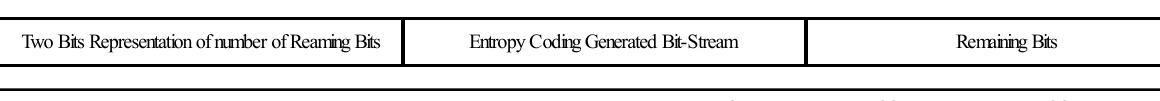
FIG. 2. FLOWCHART FOR ARITHMETIC TABLE 3. BIT HEADER OF CASCADING SPIHT AND ENTROPY CODING